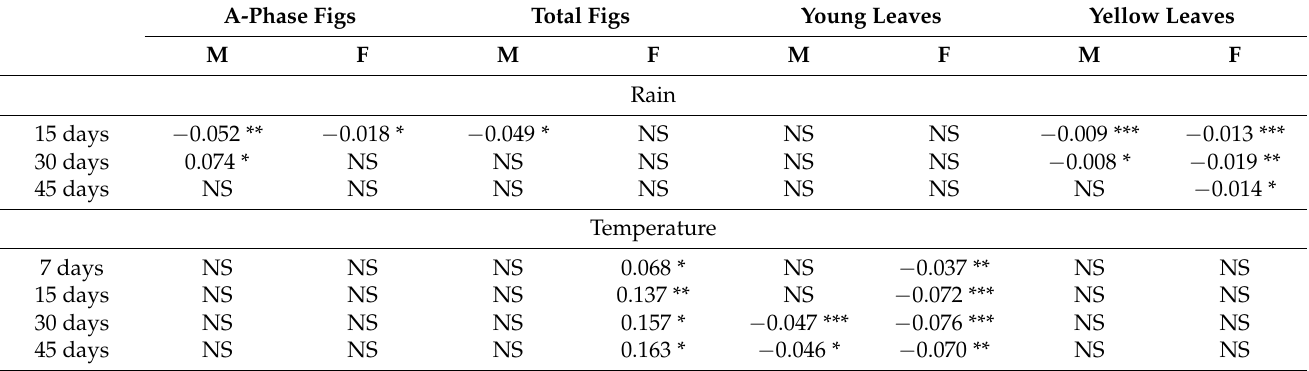
Table 3. Correlation coefficients of the generalized least (GLS) models with autocorrelated errors between phenological characteristics and climatic factors for male (M) and female (F)